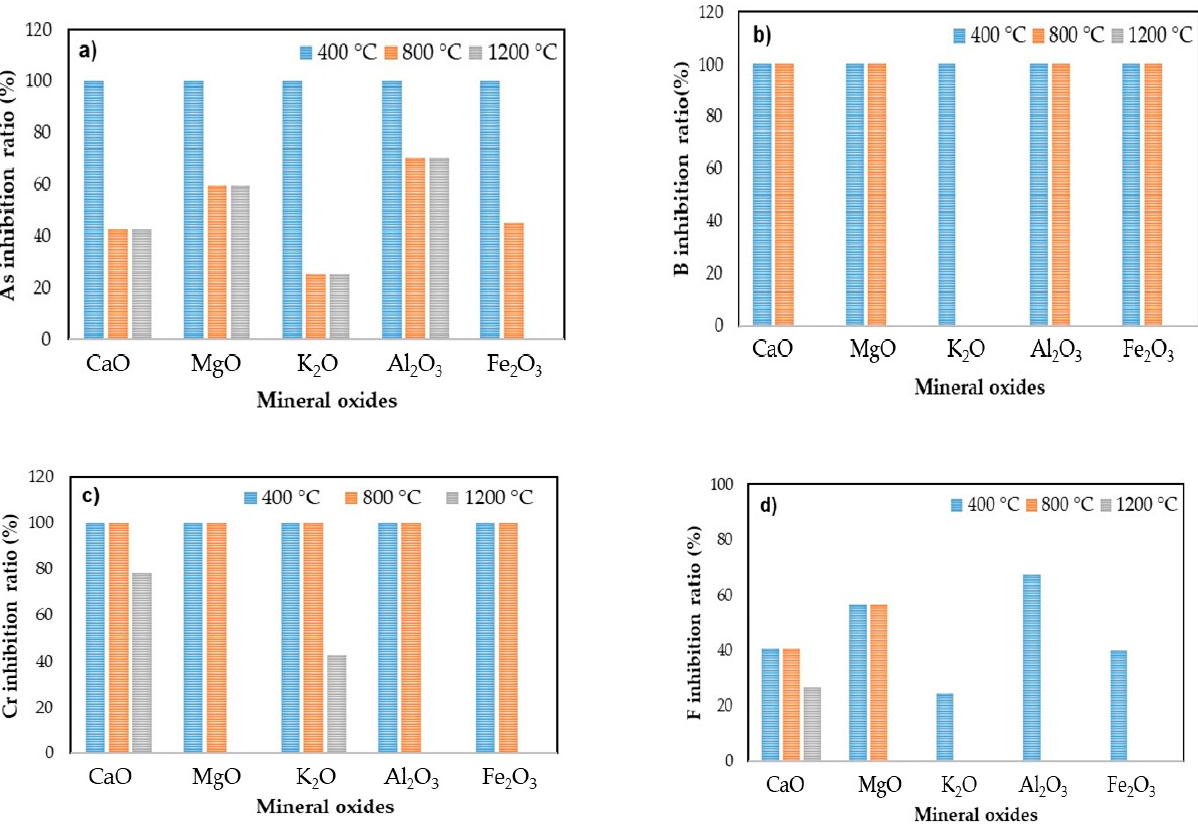
Figure 7. Impact of addition of mineral oxides on trace elements (TEs) inhibition during combustion at T = 400 ◦ C, 800 ◦ C, and 1200 ◦ C; ( a ) arsenic; ( b ) boron; ( c ) chromium, and ( d ) fluorine